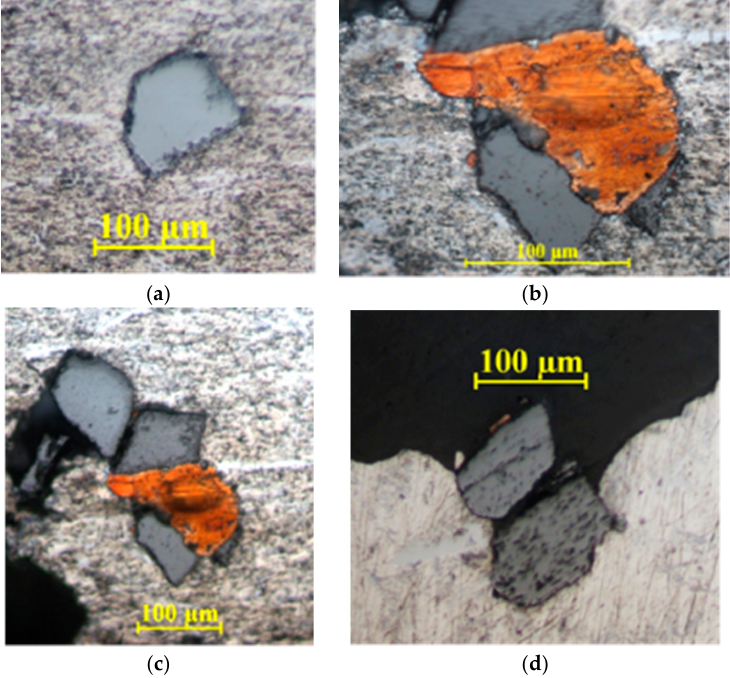
Figure 5. SiC distribution in the metallic base — V 2 . ( a ) Central embedded SiC particle (×200), ( b ) Cu on a SiC particle (×500), ( c ) SiC particles agglomeration (×200), ( d ) SiC particle embedded at sample surface (×200).